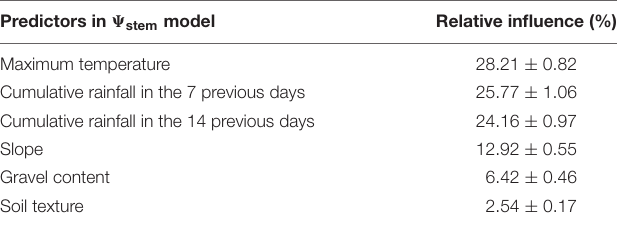
TABLE 3 | Relative influence of predictors in the solar noon stem leaf water potential ( (cid:57) stem ) model (scaled so that the sum of all relative contributions is 100).